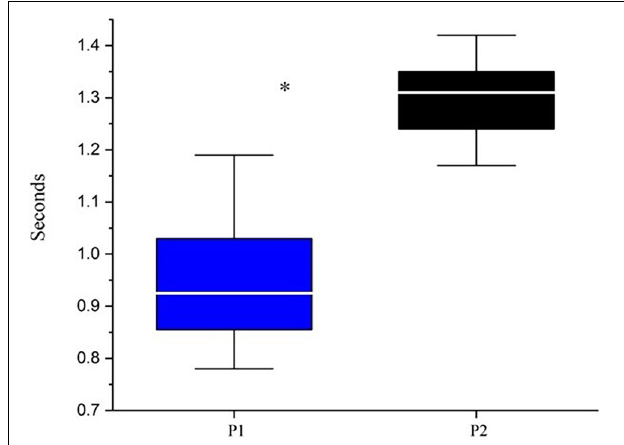
FIGURE 1 | Median and range of stride times. ∗ Indicates p < 0.05 based upon Mann-Whitney testing: U = 24.5 and p < 0.00001. P1 is represented by blue boxes, P2 by black boxes. The white line represents the median.